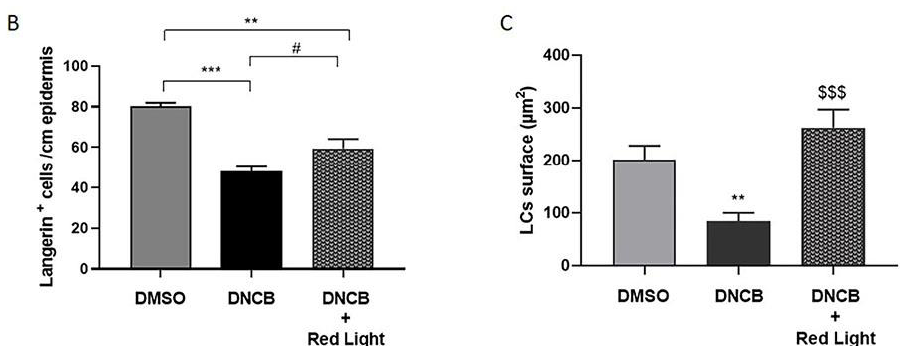
Figure 4. Red light decreases DNCB-induced LCs activation in the epidermis. Human skin explants were topically treated with the excipient (DMSO 20%) or DNCB (0.25% w / v ) with or without red light exposure (660 nm, 3 J/cm 2 , 250 s). ( A ) Langerin immunostaining was performed on frozen skin sections 24 h after DNCB treatment and revealed by AlexaFluor 488 (green). The nuclei were counterstained using propidium iodide (red). Scale bars represent 50 µm. ( B ) The absolute number of langerin-positive cells in the epidermis was counted at 2 different zones for the 3 explants of each batch. Histogram represents the mean ± SEM of 6 measures of langerin-positive cells/cm epidermis. ( C ) Langerin-positive cells total surface was measured by ImageJ software (version 1.8). Histogram represents the mean ± SEM of cell surface of 10 different measures. ANOVA followed by Tukey post hoc test; ** p < 0.01; *** p < 0.001 vs. DMSO-treated control group; # p = 0.06, $$$ p < 0.001 vs. DNCB-treated group.